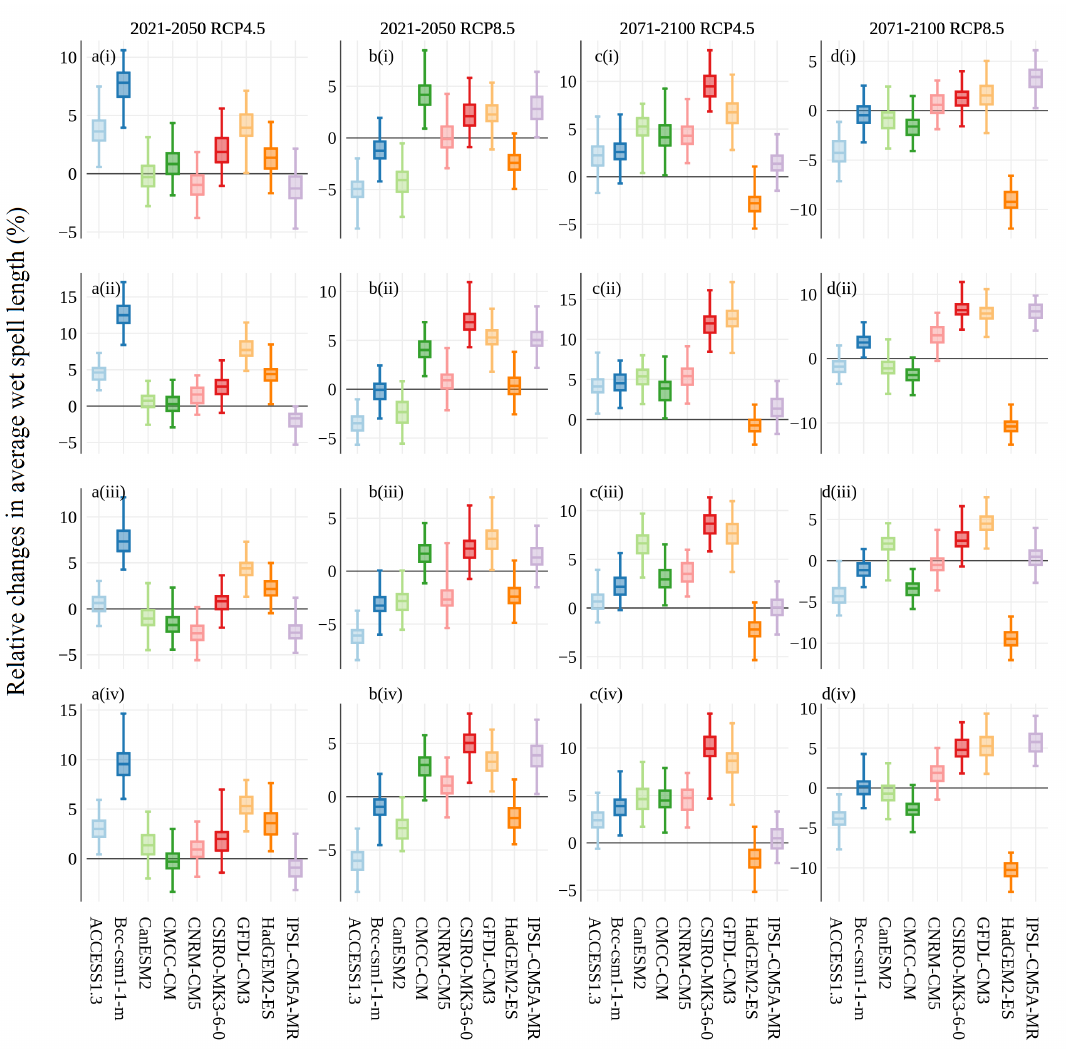
Figure 11. Relative changes (%) in average wet spell lengths from downscaled GCM data for: ( a ) 2021–2050 period under RCP4.5 scenario; ( b ) 2021–2050 period under RCP8.5 scenario; ( c ) 2071–2100 period under RCP4.5 scenario; and ( d ) 2071–2100 period under RCP8.5 scenario relative to observed values during 1985–2014. Rows ( i – iv ) denote results for stations S06, S23, S24, and S25, respectively. The bottom, middle, and top of the box denote the first, second, and third quartiles,